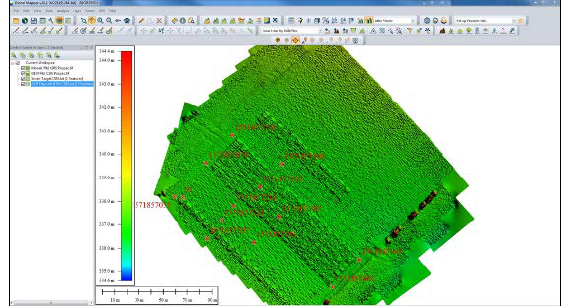
Figure 9: DEM Overlaid with GCP’s